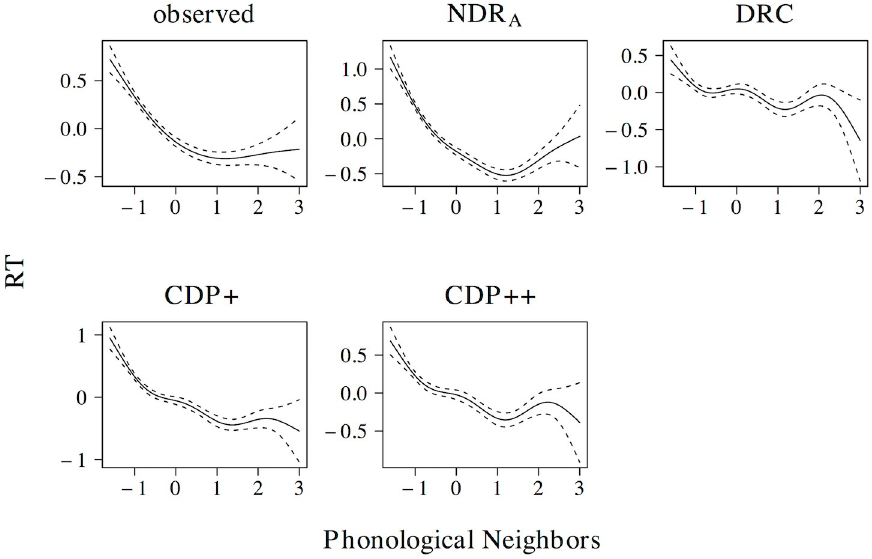
Fig 7. Phonological neighborhood density. The effect of phonological neighborhood density in word